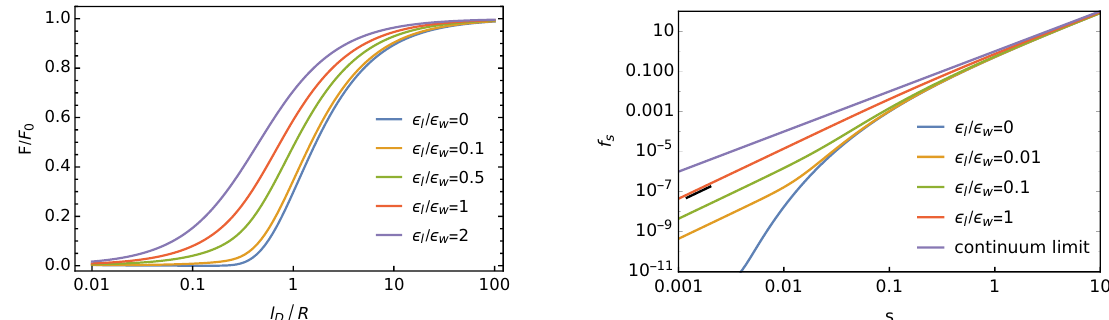
Figure 6. Left diagram: Scaled Debye-Hückel free energy F / F 0 for an ensemble of discrete point charges as a function of (cid:112) e / ( σ 0 π ) being the radius of the Wigner–Seitz cell. Different curves correspond the scaled Debye length l D / R , with R = to ε l / ε w = 0 (blue), ε l / ε w = 0.1 (orange), ε l / ε w = 0.5 (green), ε l / ε w = 1 (red), and ε l / ε w = 2 (purple). Right diagram: The ε w ε 0 F / ( e 2 A ) as a function of the scaled surface charge density s = l 2 scaled free energy f s = 2 l 3 D (blue), ε l / ε w = 0.01 (orange), ε l / ε w = 0.1 (green), and ε l / ε w = 1 (red). The uppermost straight line (shown in purple) corresponds to the continuum limit f s = s 2 where the discreteness of the charges is ignored (see also Equation (1)). The short black line segment close to the red line is a guide to the eye; it has a slope of 2.5 and thus indicates a behavior f s ∼ s 2.5 , as observed for non-vanishing ε l / ε w in the limit of small s